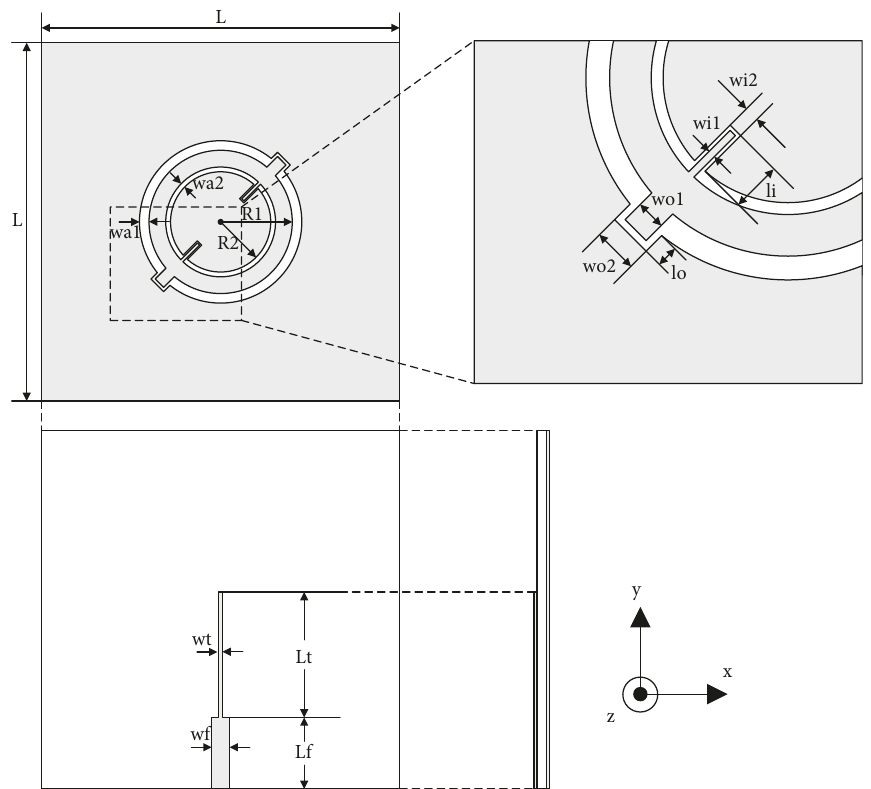
Figure 1: Both positive and negative side of the proposed dual-band LHCP annular-ring slot antenna.